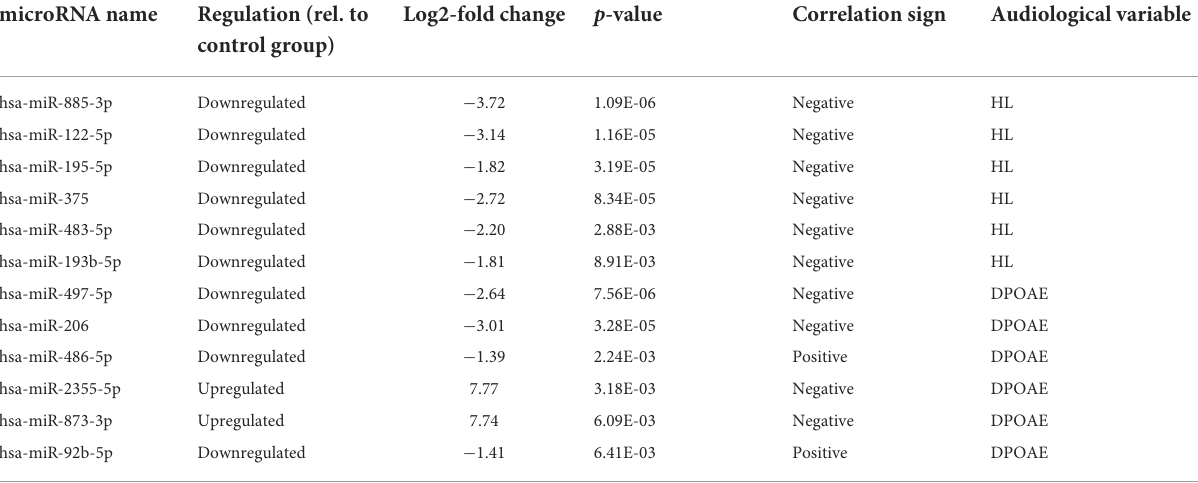
TABLE 1 List of the differentially expressed microRNAs significantly associated with the audiological variables, either HL or DPOAE level.